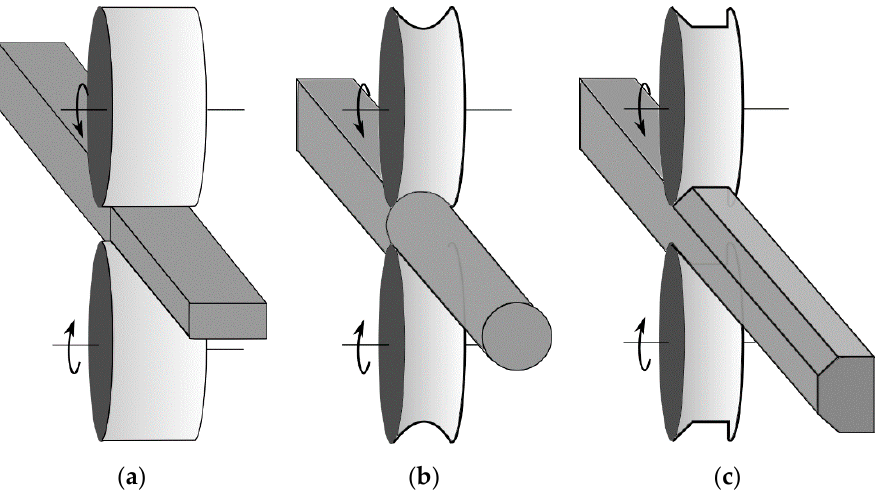
Figure 1. Different types of rolls: ( a ) flat, ( b ) round, and ( c ) non-symmetric. Figure 1. Di ff erent types of rolls: ( a ) flat, ( b ) round, and ( c )